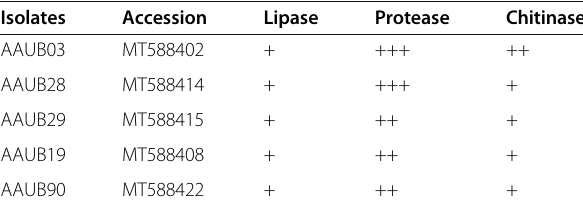
Table 4 Extracellular enzyme production of five selected strains on agar culture medium